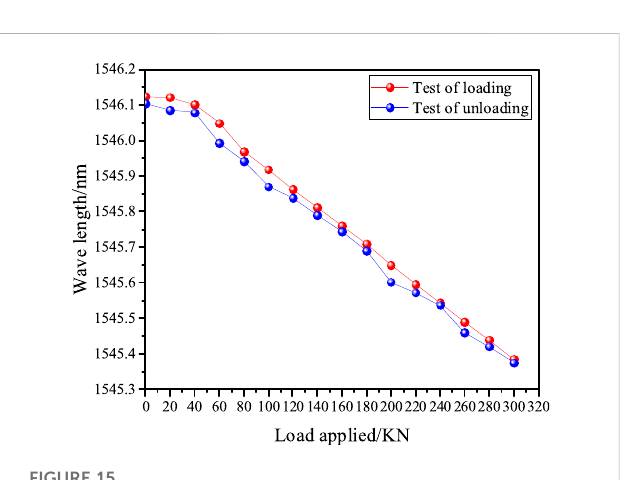
FIGURE 15 Changing curve between the pressure and